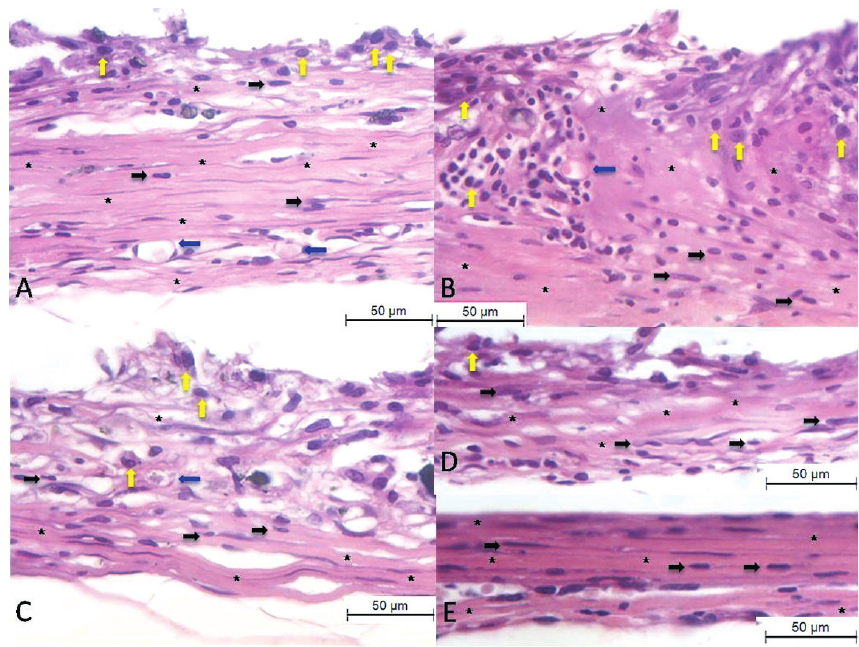
Figure 2- Histological images of inflammatory cells infiltration at the end of implanted tubes at the end of the 60-day period. (A) GMTA. (B) WPC. (C) GPC Minetti. (D) GPC Votoran. (E) Control group. Presence of collagen fibers arranged to the cement (asterisks), fibroblasts (black arrows), blood vessels (blue arrows) and macrophages/multinucleated giant cells (yellow arrows). Hematoxylin and eosin staining, bars represent 50